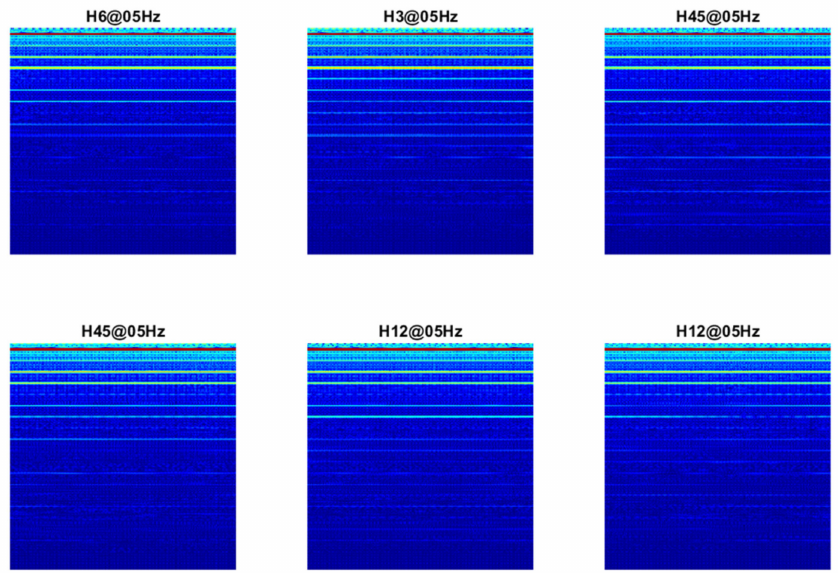
Figure 17. Examples of spectrograms of the current signal with localized fault and with LFTO condition. The decimation factor used was